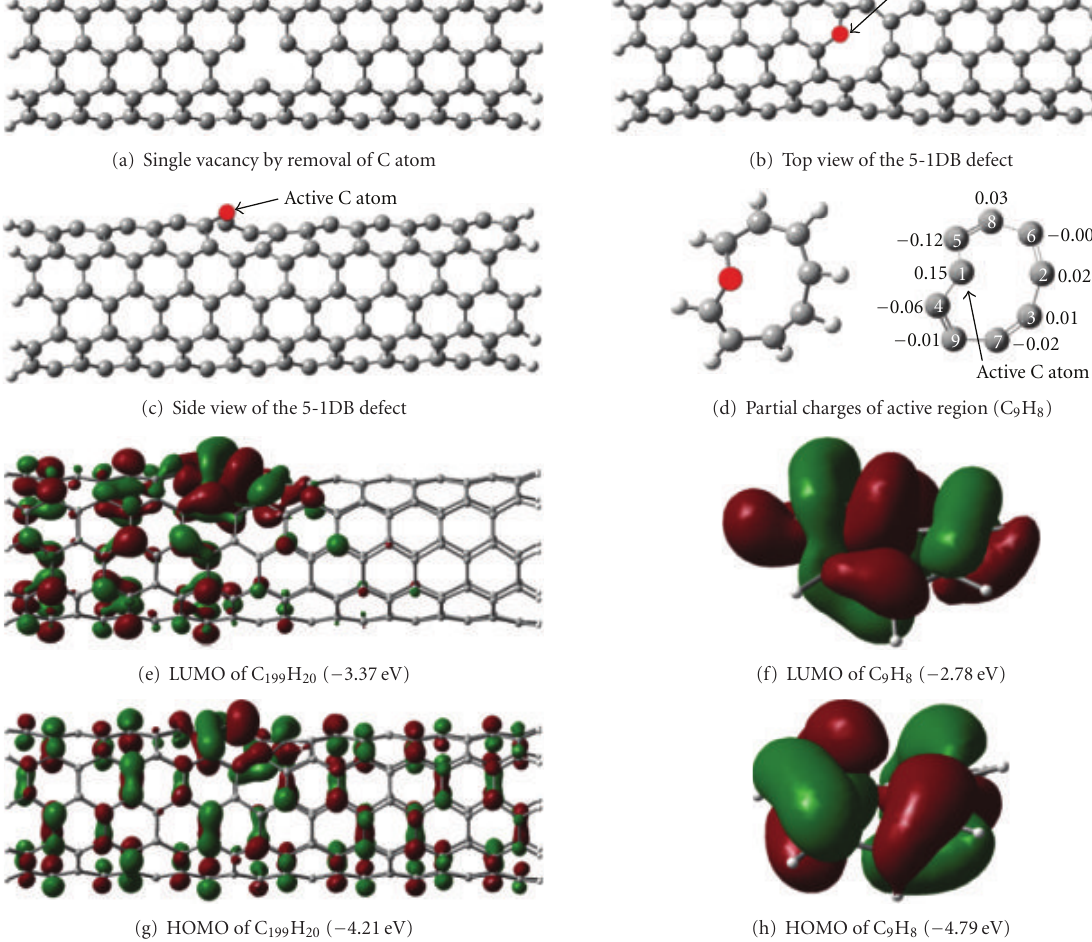
Figure 5: Optimized geometry and FMOs of a 5-1DB defected SWCNT and higher-layer model C 9 H 8 . Orbital energies are in parentheses [81]. Legend: dark grey = carbon, light grey =